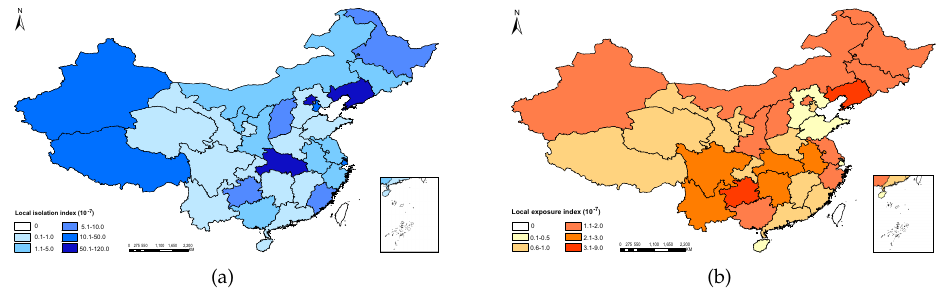
Figure 10. ( a ) Local isolation index of ASF cases from 1 August 2018 to 31 August 2019. ( b ) Local exposure index of ASF cases from 1 August 2018 to 31 August